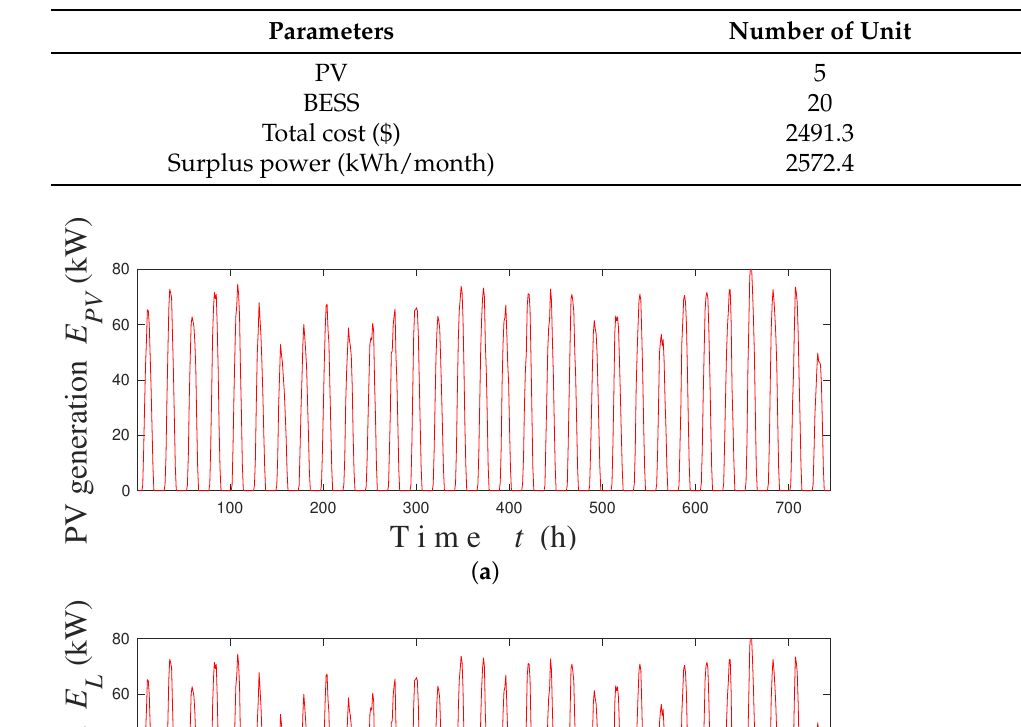
Table 12. Simulation results of case 1.